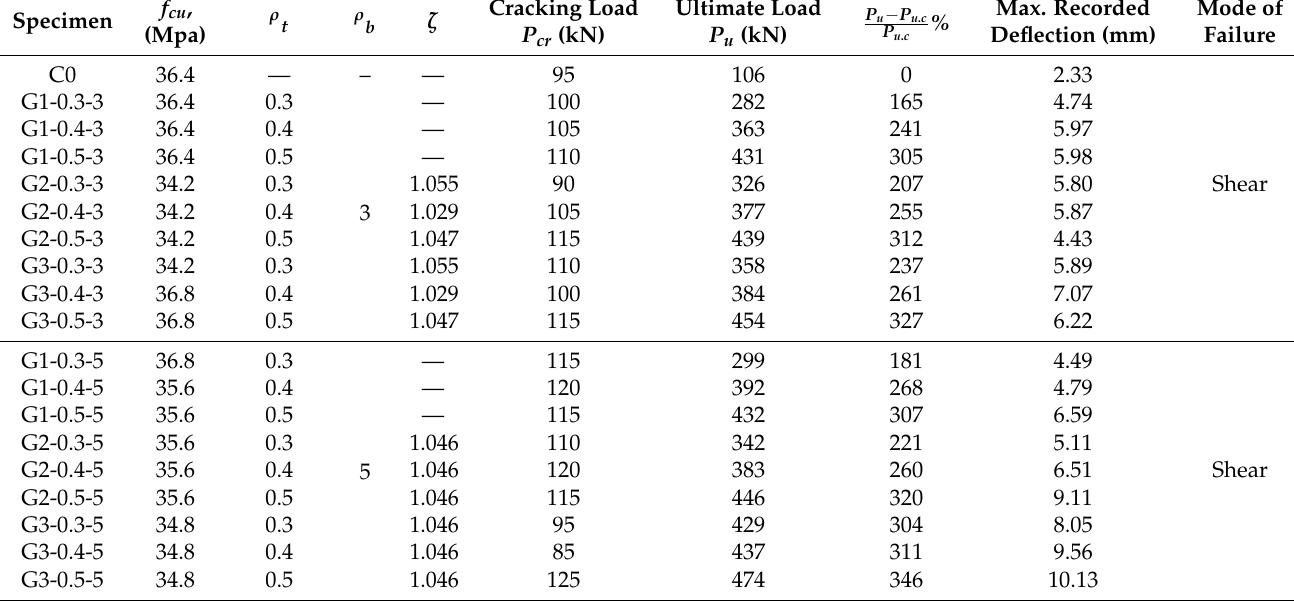
Table 2. Experimental results of